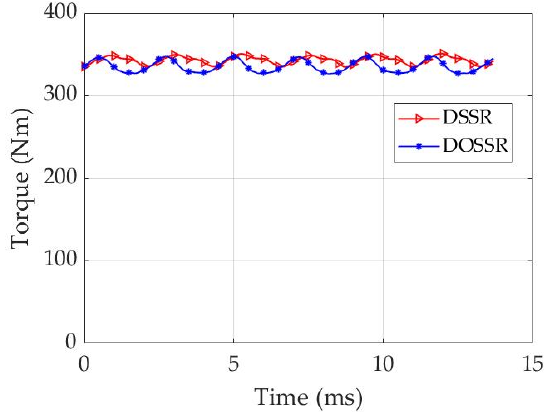
Figure 13. Torque for the DSSR motor with PM thickness of 4.5 mm and the DOSSR motor with PM thickness of 5 mm.